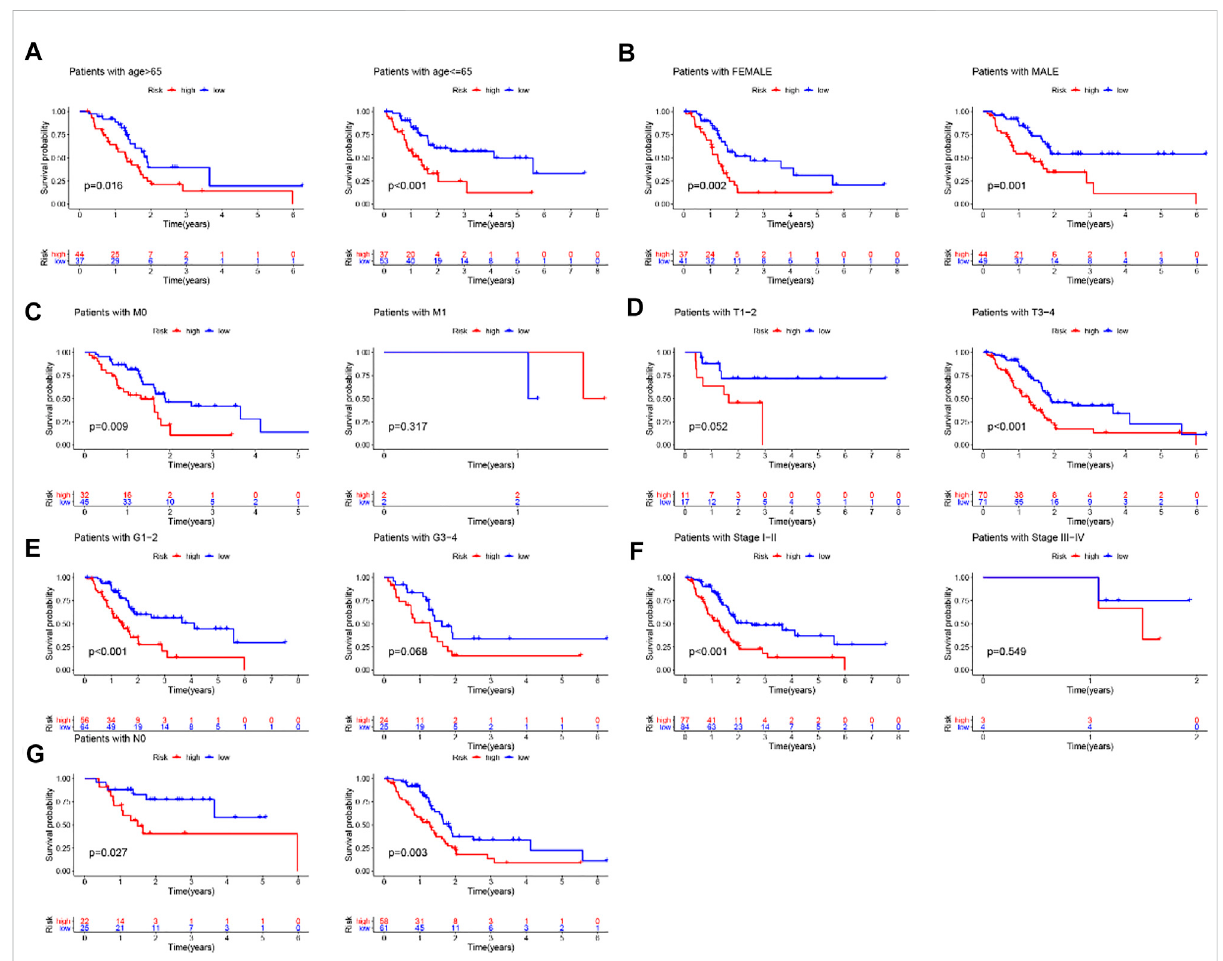
FIGURE 8 Strati fi cation analysis by age, gender and pathological grade and stage. (A) Kaplan-Meier curve analysis of overall survival in low-/high-risk groups for age. (B) Kaplan-Meier curve analysis of overall survival in low-/high-risk groups for gender. (C,D,G) Kaplan-Meier curve analysis of overall survival in low-/high-risk groups based on tumor size, lymph node metastasis and distant metastasis. (E) Kaplan-Meier curve analysis of overall survival in low-/high-risk groups for the grade. (F) Kaplan-Meier curve analysis of overall survival in low-/high-risk groups for